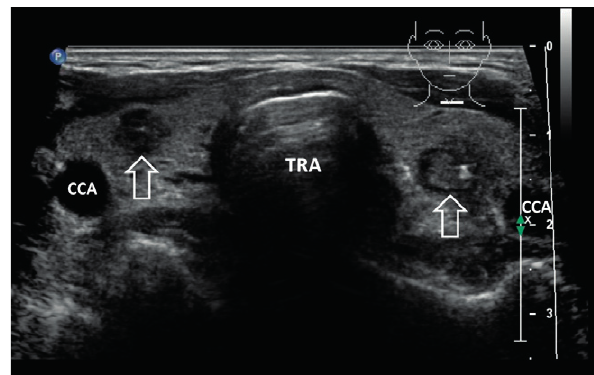
Fig. 3b. Twelve months post 2× simultaneous PEIT. small solid nodules (empty arrows) as residue of cysts, no re- currence of the liquid component: in the right lobe size 8 × 6 × 5 mm and volume 0.2 mL, inhomogeneous structure, slightly hypoechoic, tiny punctuations of fibrosis and in the left lobe size 10 × 7 × 7 mm and volume 0.3 mL, inhomogeneous struc- ture, mostly isoechoic, tiny punctuations of fibrosis, anechoic “halo”;